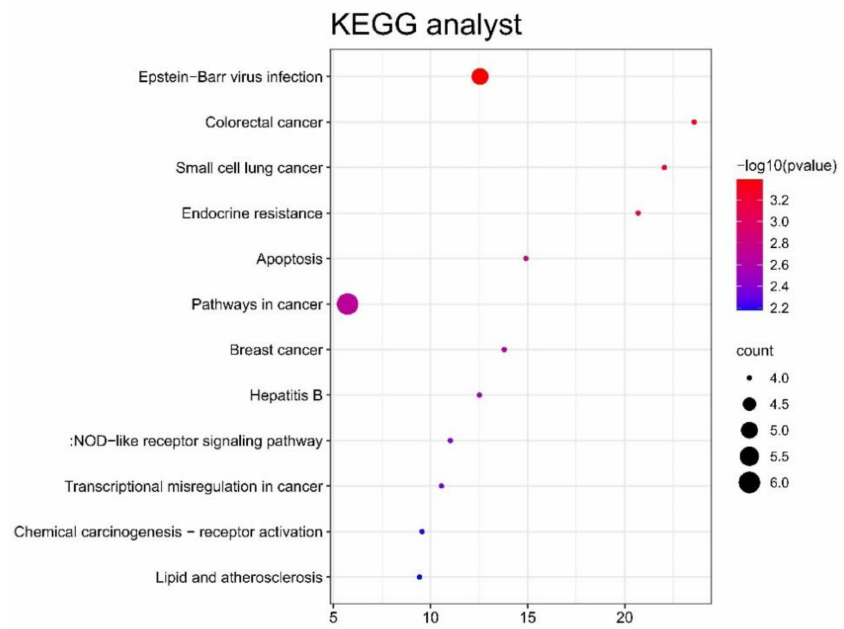
Figure 4. Significant KEGG pathways of upregulated DEGs.